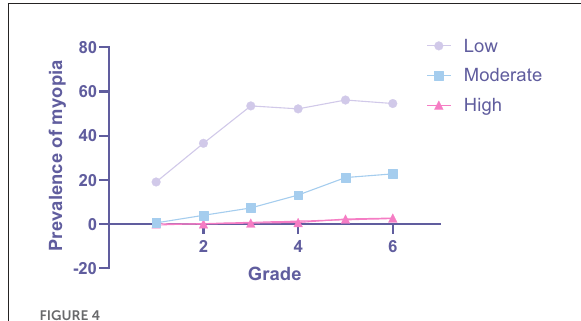
FIGURE4 Grade specific incidence of in different categories of